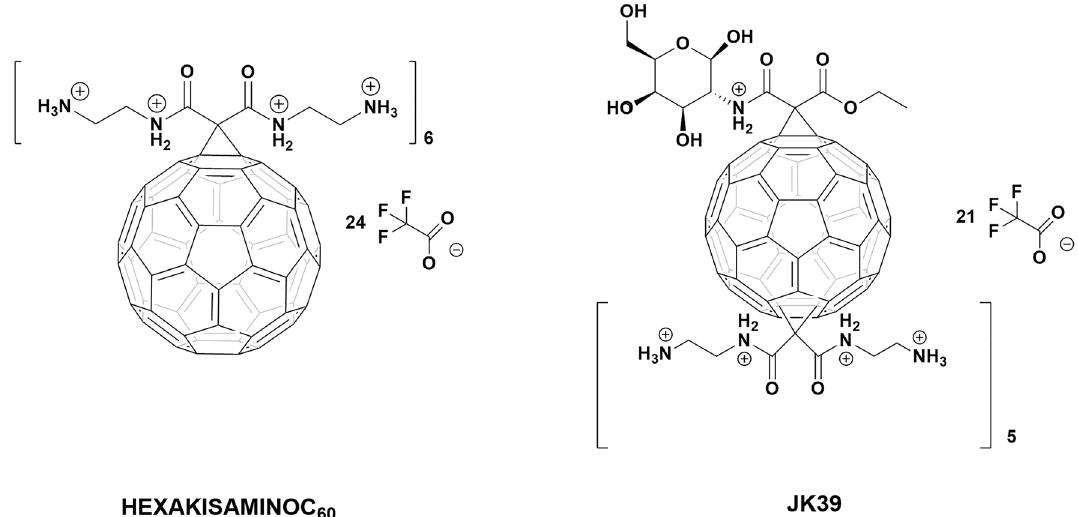
Figure 1. The non-viral cationic fullerene nanomaterials HexakisaminoC 60 and JK39 that were used for the siRNA